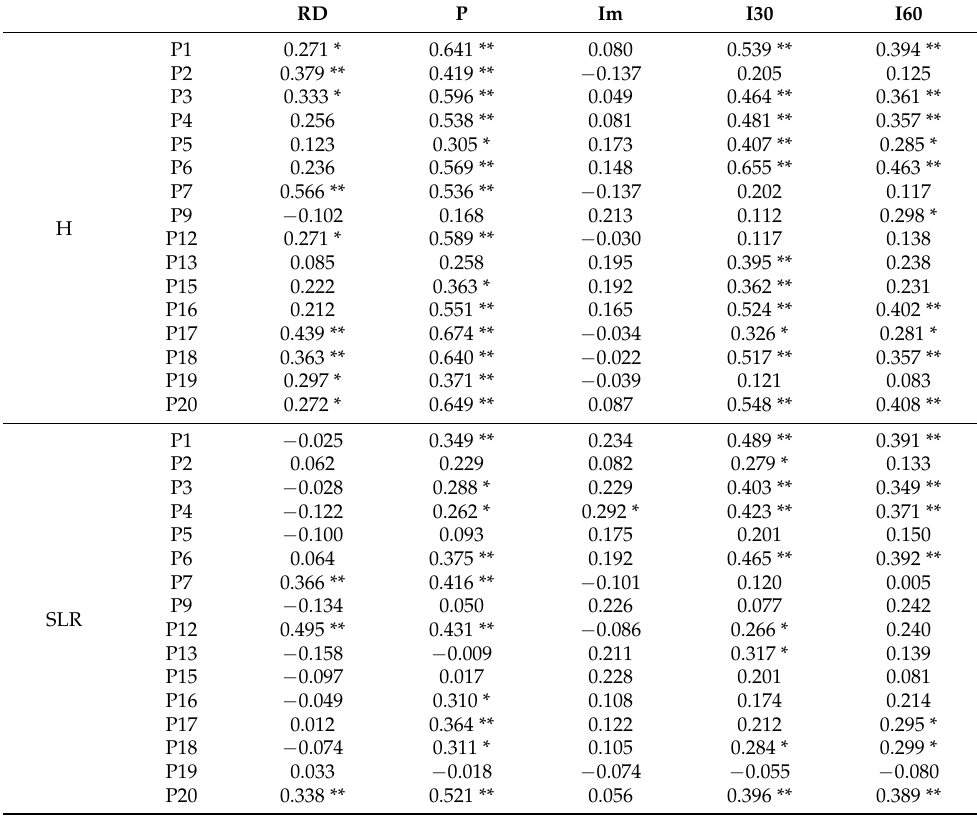
Table 4. The matrix of Pearson correlation coefficients among the five rainfall properties of the 57 erosive rainfall events, runoff depth (H) and soil loss rate (SLR), during 2014–2019. RD P Im I30